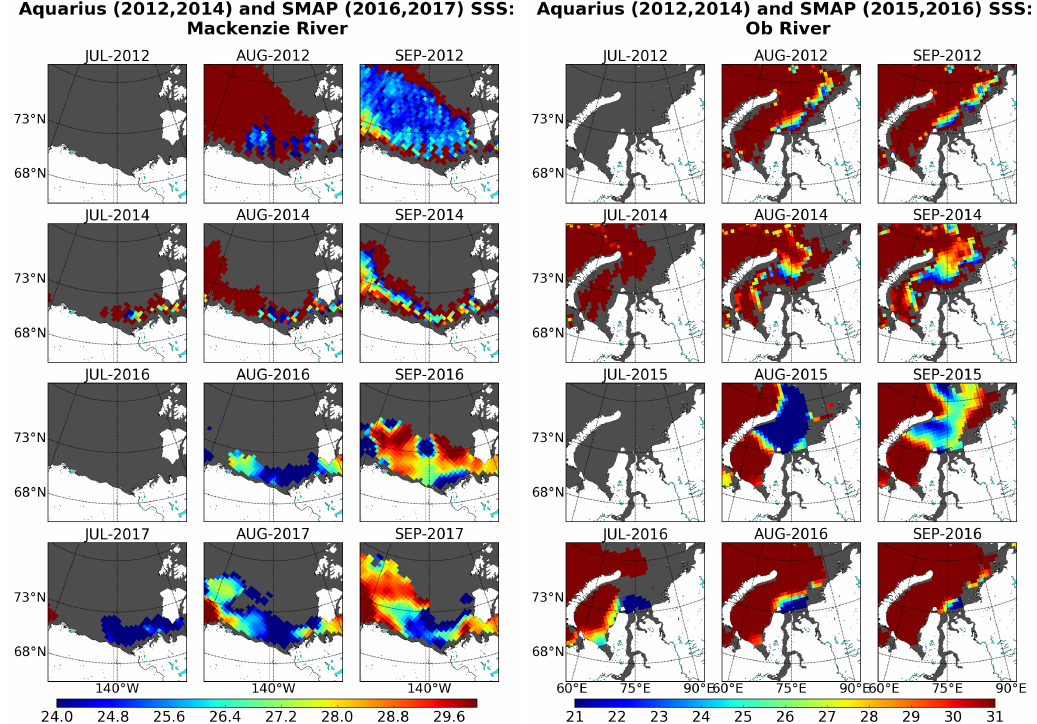
Figure 13. Monthly Aquarius and SMAP SSS maps close to the mouth of: Mackenzie River ( left ); and Ob River ( right